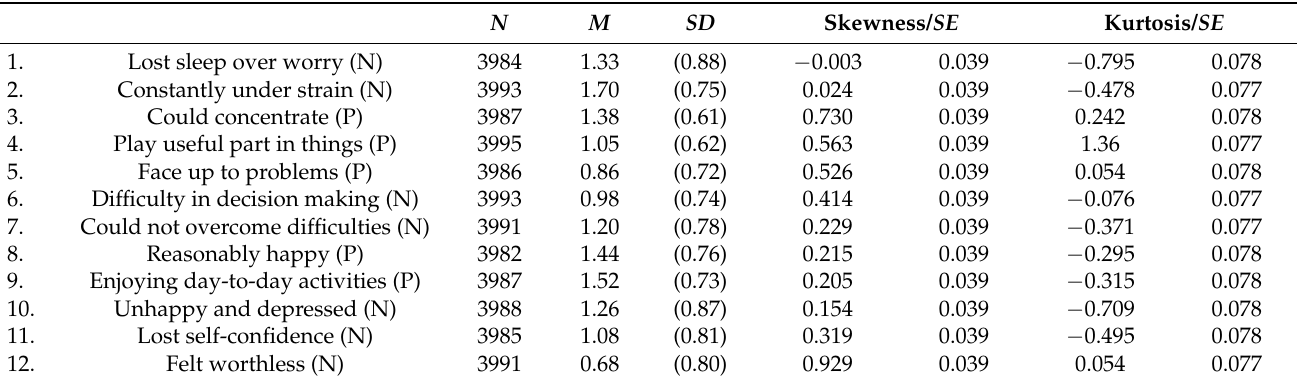
Table 3. The statistics for the GHQ-12